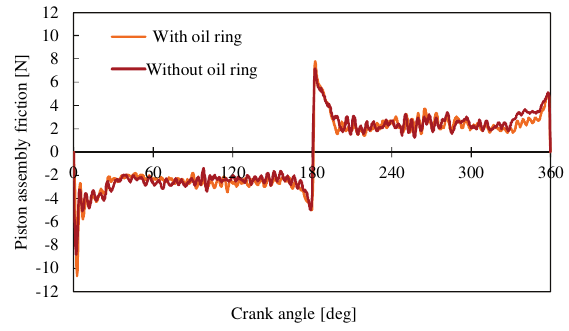
Fig. 12. Effect of absence of oil ring on piston assembly friction at 80°C and 1000 rpm At more than 800 rpm, the friction with the one-ring set at 80°C increased around TDC and BDC beyond that at 60°C (Fig. 14). At 80°C, the oil viscosity is reduced, so the